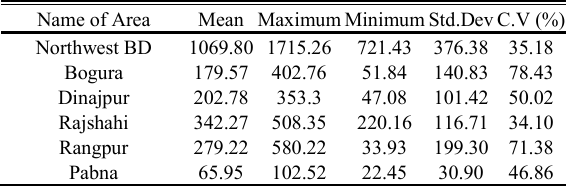
Table 6 . Coefficient of variation (%) in wetland areal coverage Name of Area